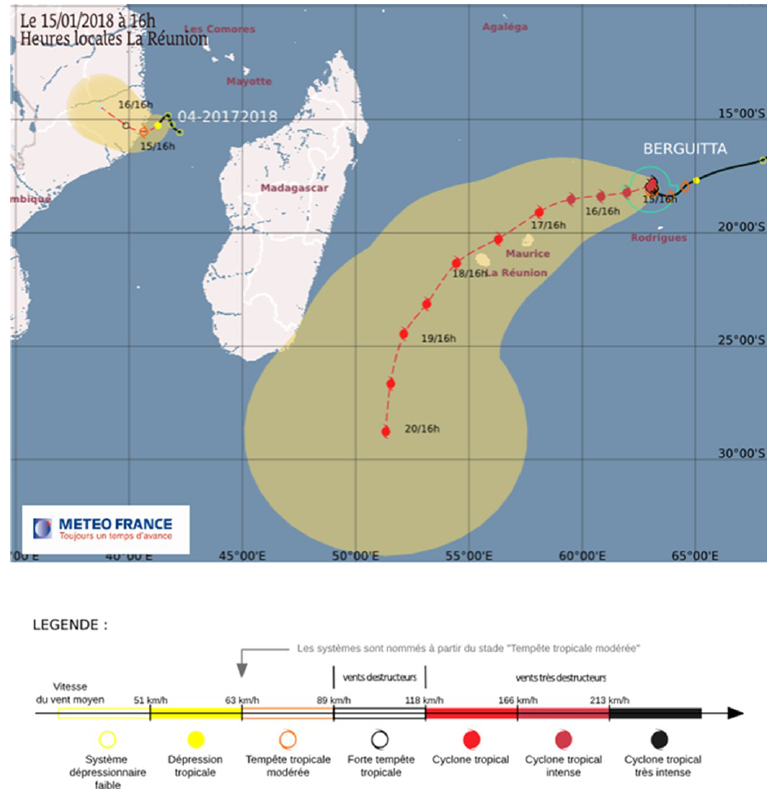
Figure 2. Evolution of the 2018 low-pressure system that formed in the Mozambique Channel on 13 January 2018. (Source: Meteo France, license